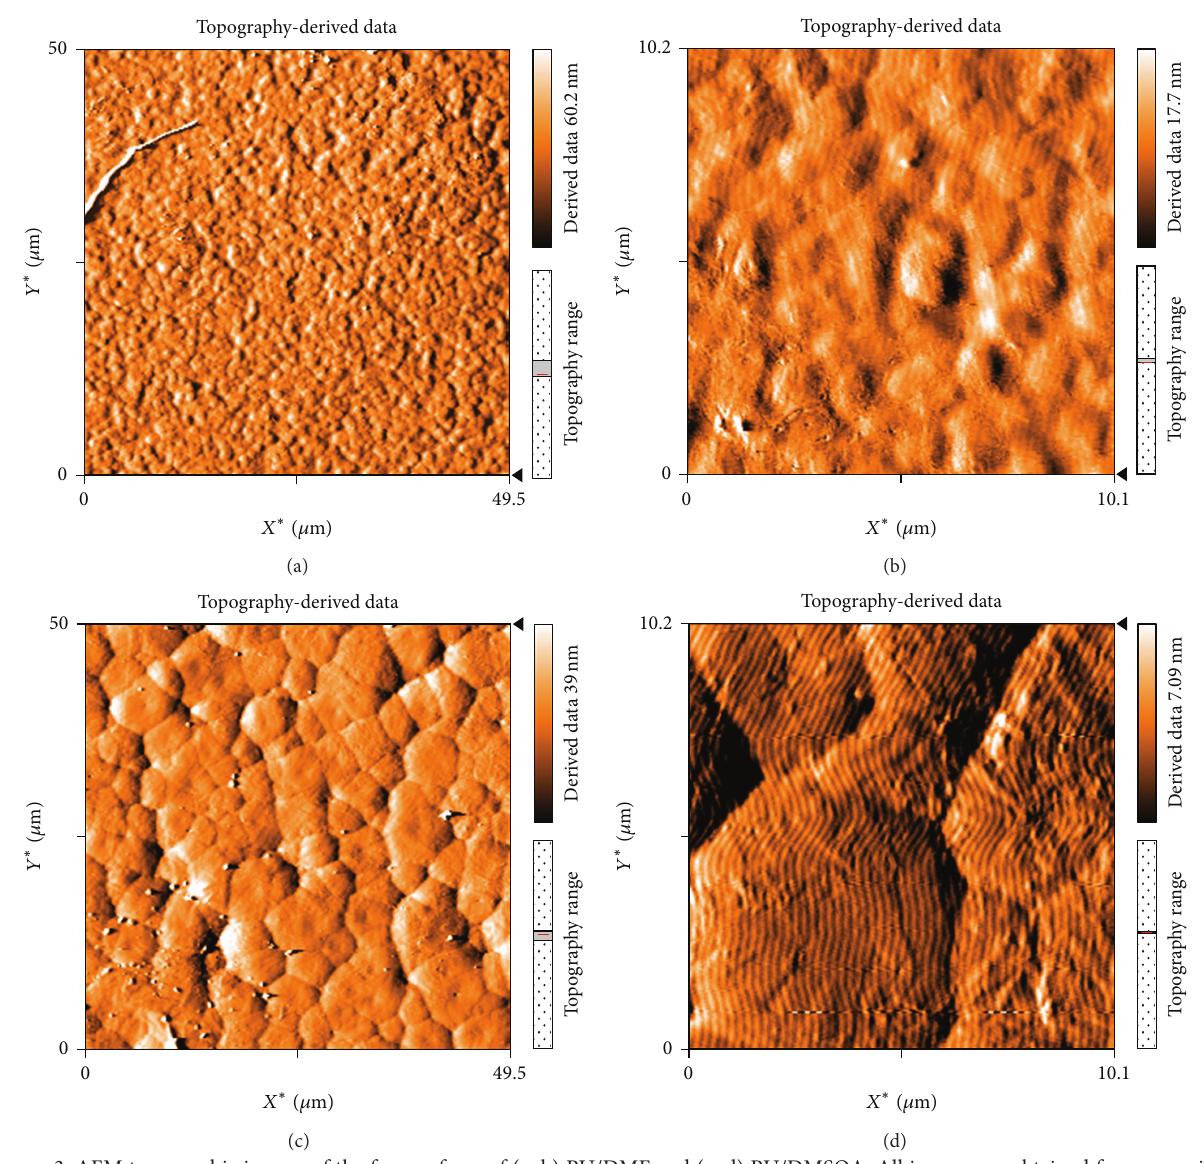
Figure 3: AFM topographic images of the free surfaces of (a, b) PU/DMF and (c, d) PU/DMSOA. All images are obtained from scanning rate at 1s/line and 250